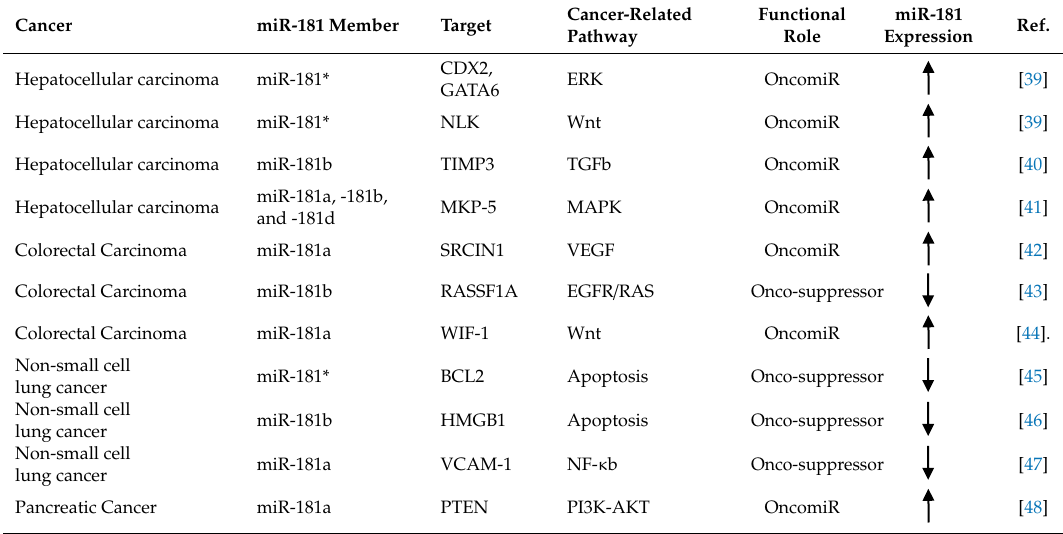
Table 2. The functional role of the miR181 family in cancer.